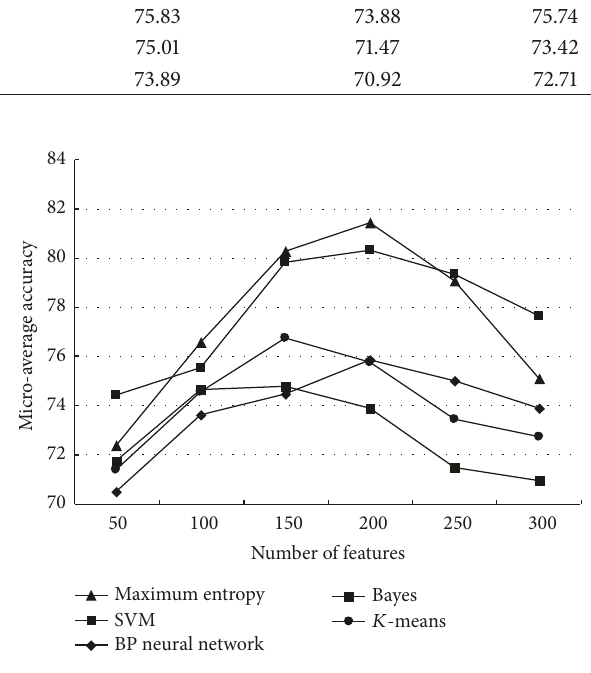
Figure 4: Micro-average accuracy comparison among different classification